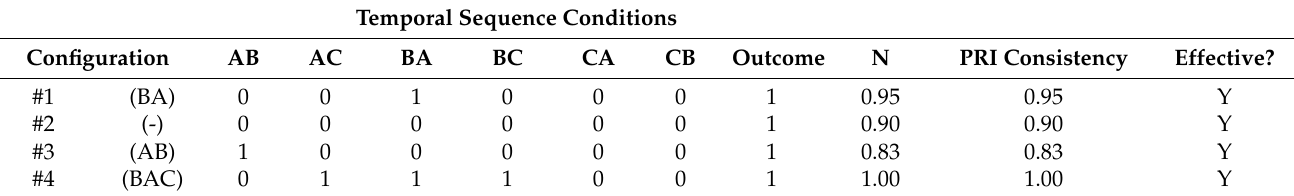
Table 9. The visual scan path configuration (Hazard #3).